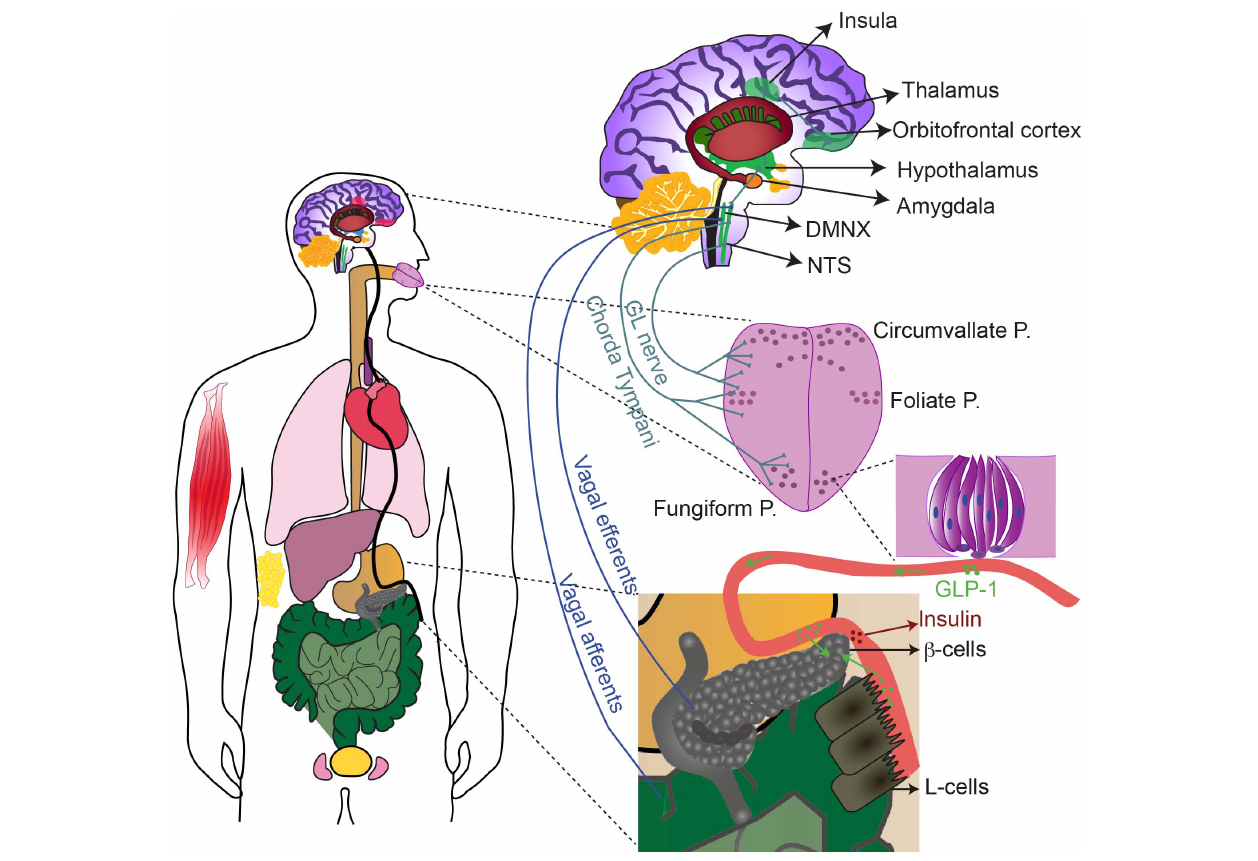
FIGURE 2 | The sweet taste receptor contributes to gustation and extraoral sugar-sensing. T1R2/T1R3, and possibly T1R3 homomers, are expressed with their downstream signaling molecules in multiple extraoral tissues (in color), including: oesophagus, stomach, liver, pancreas, intestine, bladder, testis, skeletal muscle, respiratory tract and adipose tissue. Activation of sweet-sensitive taste bud cells leads to purinergic stimulation of the chorda tympani and the glossopharyngeal (GL) nerves that send information, upon relay in the NTS and the thalamus, up to the insula. The insula communicates with several other brain regions (some are depicted) to regulate reward, motivation and energy homeostasis. Taste bud cells release also GLP-1 that can activate the afferent fibers as well. Sweet stimulation of taste bud cells thereby generates CPIR, possibly via NTS-DMNX communication and consequent activation of efferent vagal fibers. GLP-1 released by taste bud cells in the circulation, may also reach the pancreas, the intestine and the brain, exerting there paracrine